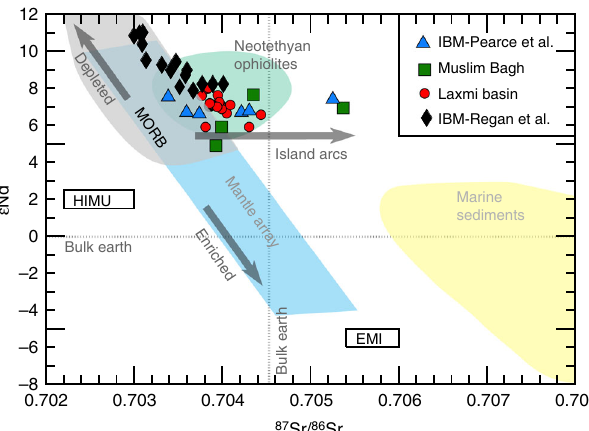
Fig. 4 Radiogenic isotope ratios of Laxmi basin lavas. Plot shows 87 Sr/ 86 Sr versus ɛ Nd parameter for LB lava (age corrected for in-growth to pre- Deccan time ~66 Myr ago). Symbols as labelled on the diagram. Reference domains are adopted from published literature (MORB 68 , Neothethyan ophiolites 69 , IBM 31,33,34,41,42 , Muslim Bagh 44,45 slab fl uid derived fl ux is observed on the Ba/Th versus Th plot